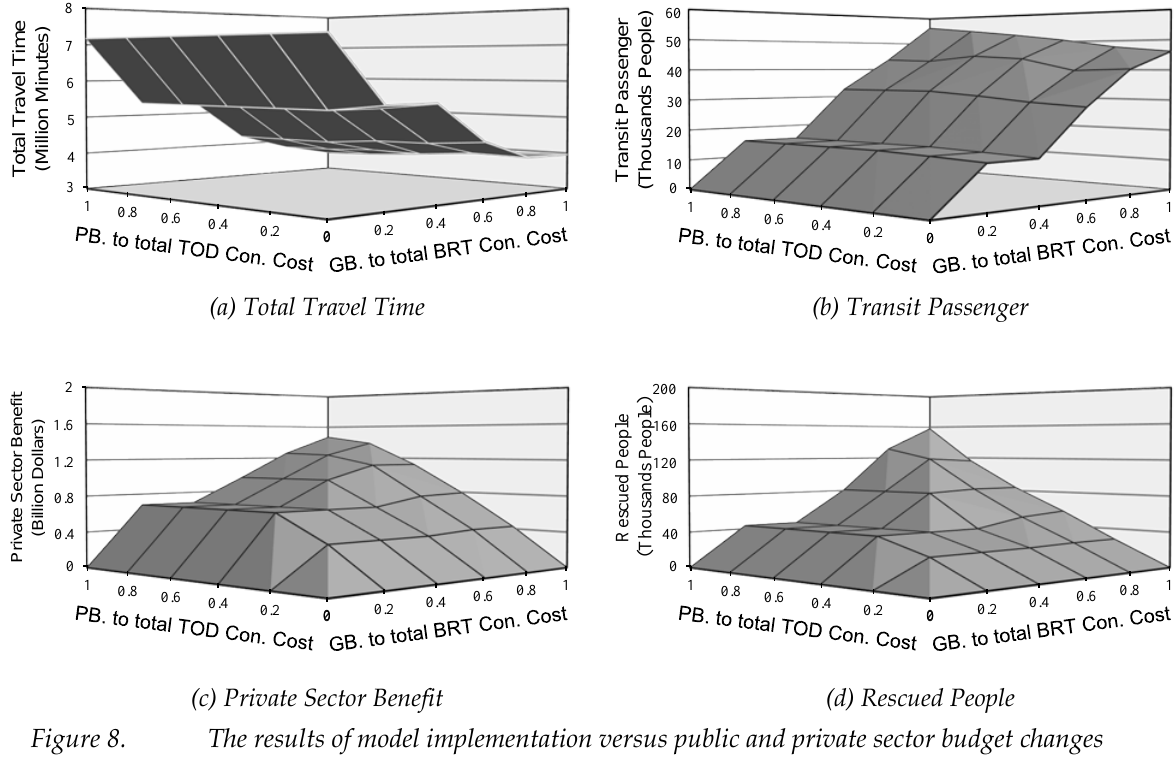
Figure 8. The results of model implementation versus public and private sector budget